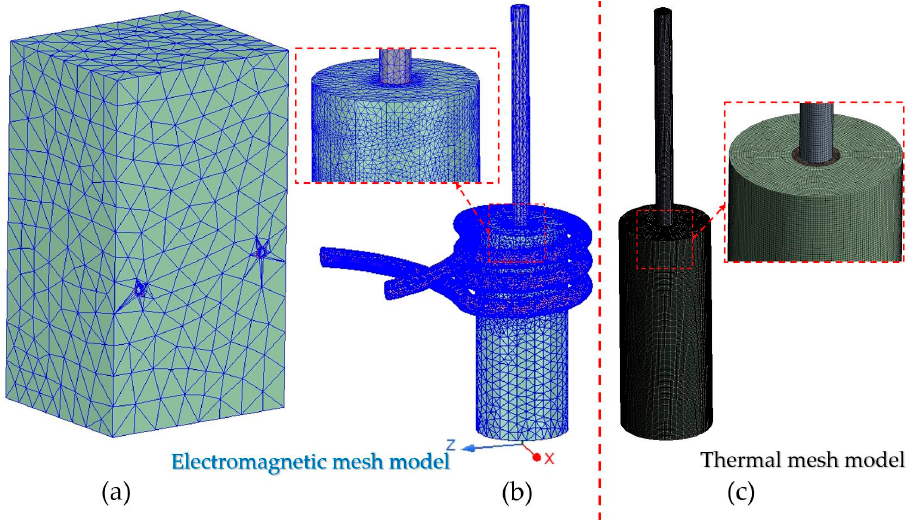
Figure 9. Mesh models for ( a , b ) electromagnetic simulation and ( c ) thermal simulation.